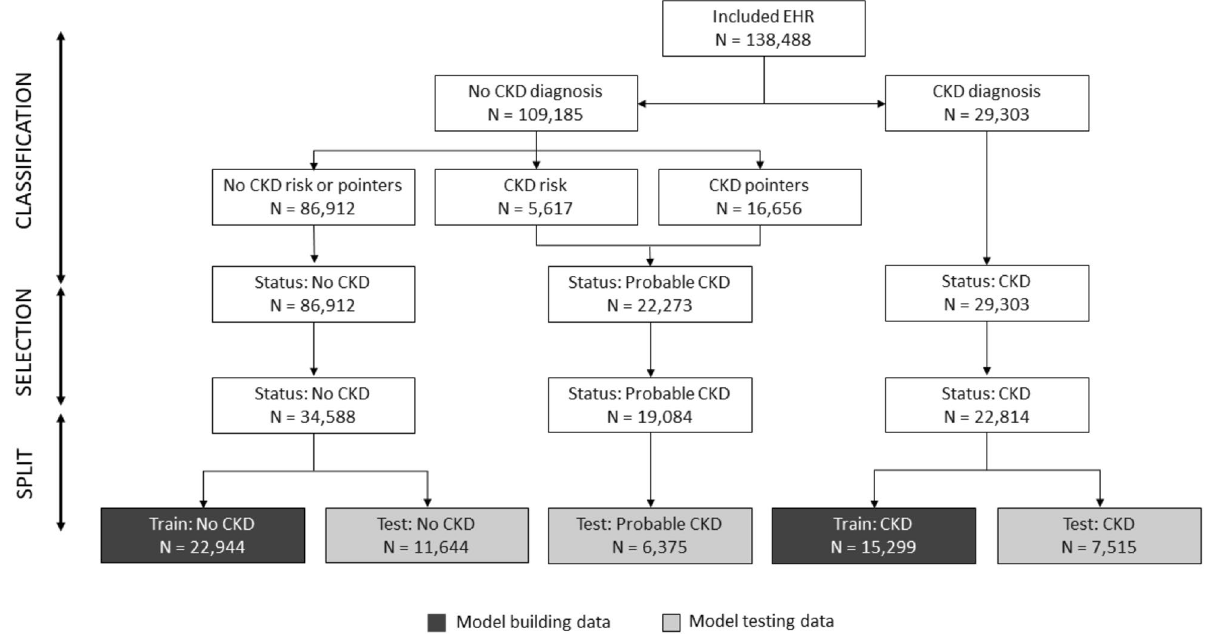
Figure 1. Schematic representation of EHR processing. Starting from the EHR subset with sufficient information for classification (‘Included EHR’) EHR are classified into 3 CKD status groups based on clinical diagnosis, risk and other pointers for CKD in the record. Subsequently records with sufficient visits and blood/ urine data prior to the evaluation visit are selected. Finally the EHR are split randomly in training and test sets. For the ‘CKD probable’ status group the training set is not shown as it was not used in the study. EHR, electronic health